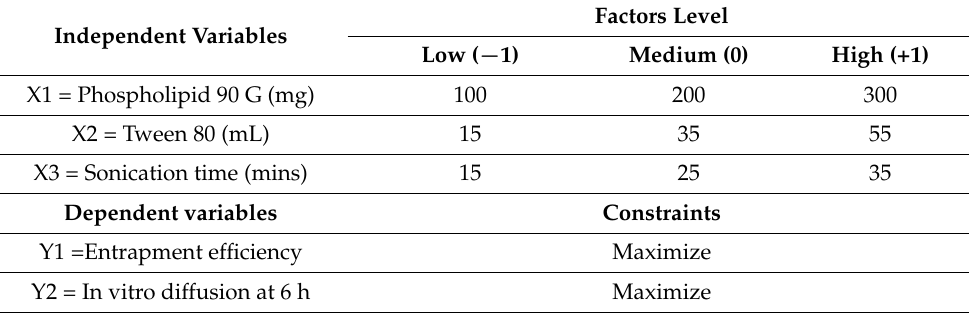
Table 1. Variables and their levels.